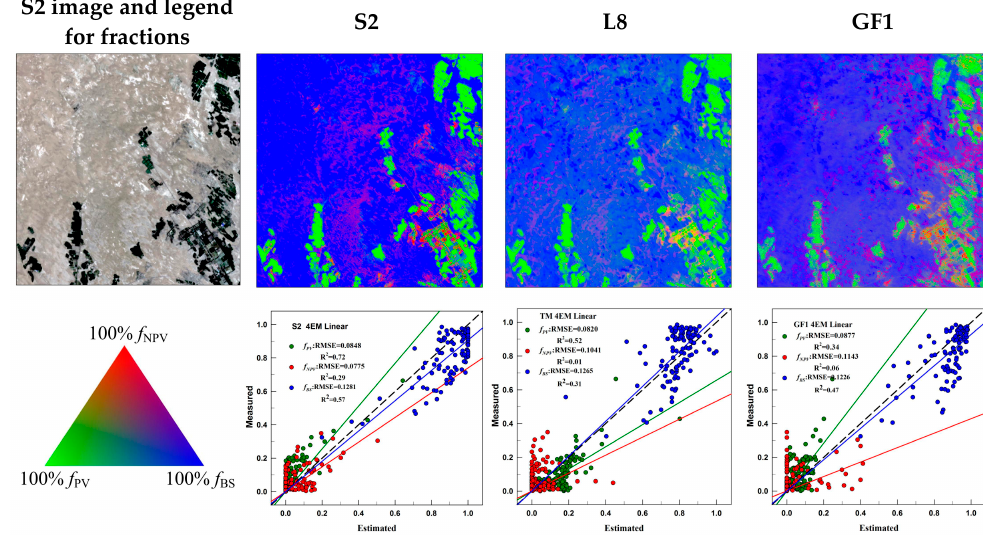
Figure 7. Endmember fraction maps and scatterplots. Fraction maps estimated by Sentinel-2 with eleven bands and 10 m spatial resolution, Landsat-8 with six bands and 30 m spatial resolution, and GF1 with four bands and 16 m spatial resolution by linear spectral-mixture model (LSMM). Scatterplots illustrate the relation between estimated and reference fractional cover of PV, NPV, and BS estimated by Sentinel-2, Landsat-8, and GF1. Dotted line shows 1:1 agreement; linear fit between measured and estimated value shown by full line. R 2 and RMSE are also shown. N = 111 in all circumstances.